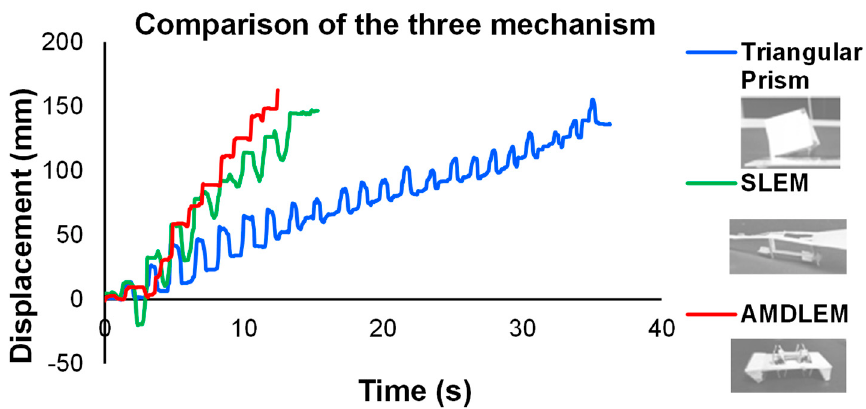
Figure 13. Horizontal displacement (mm) versus time (s) for different mechanism designs. The mechanisms generally have a similar actuation frequency at 0.6 Hz. However, the actual frequency might vary versus time due to the human error of manual actuation.